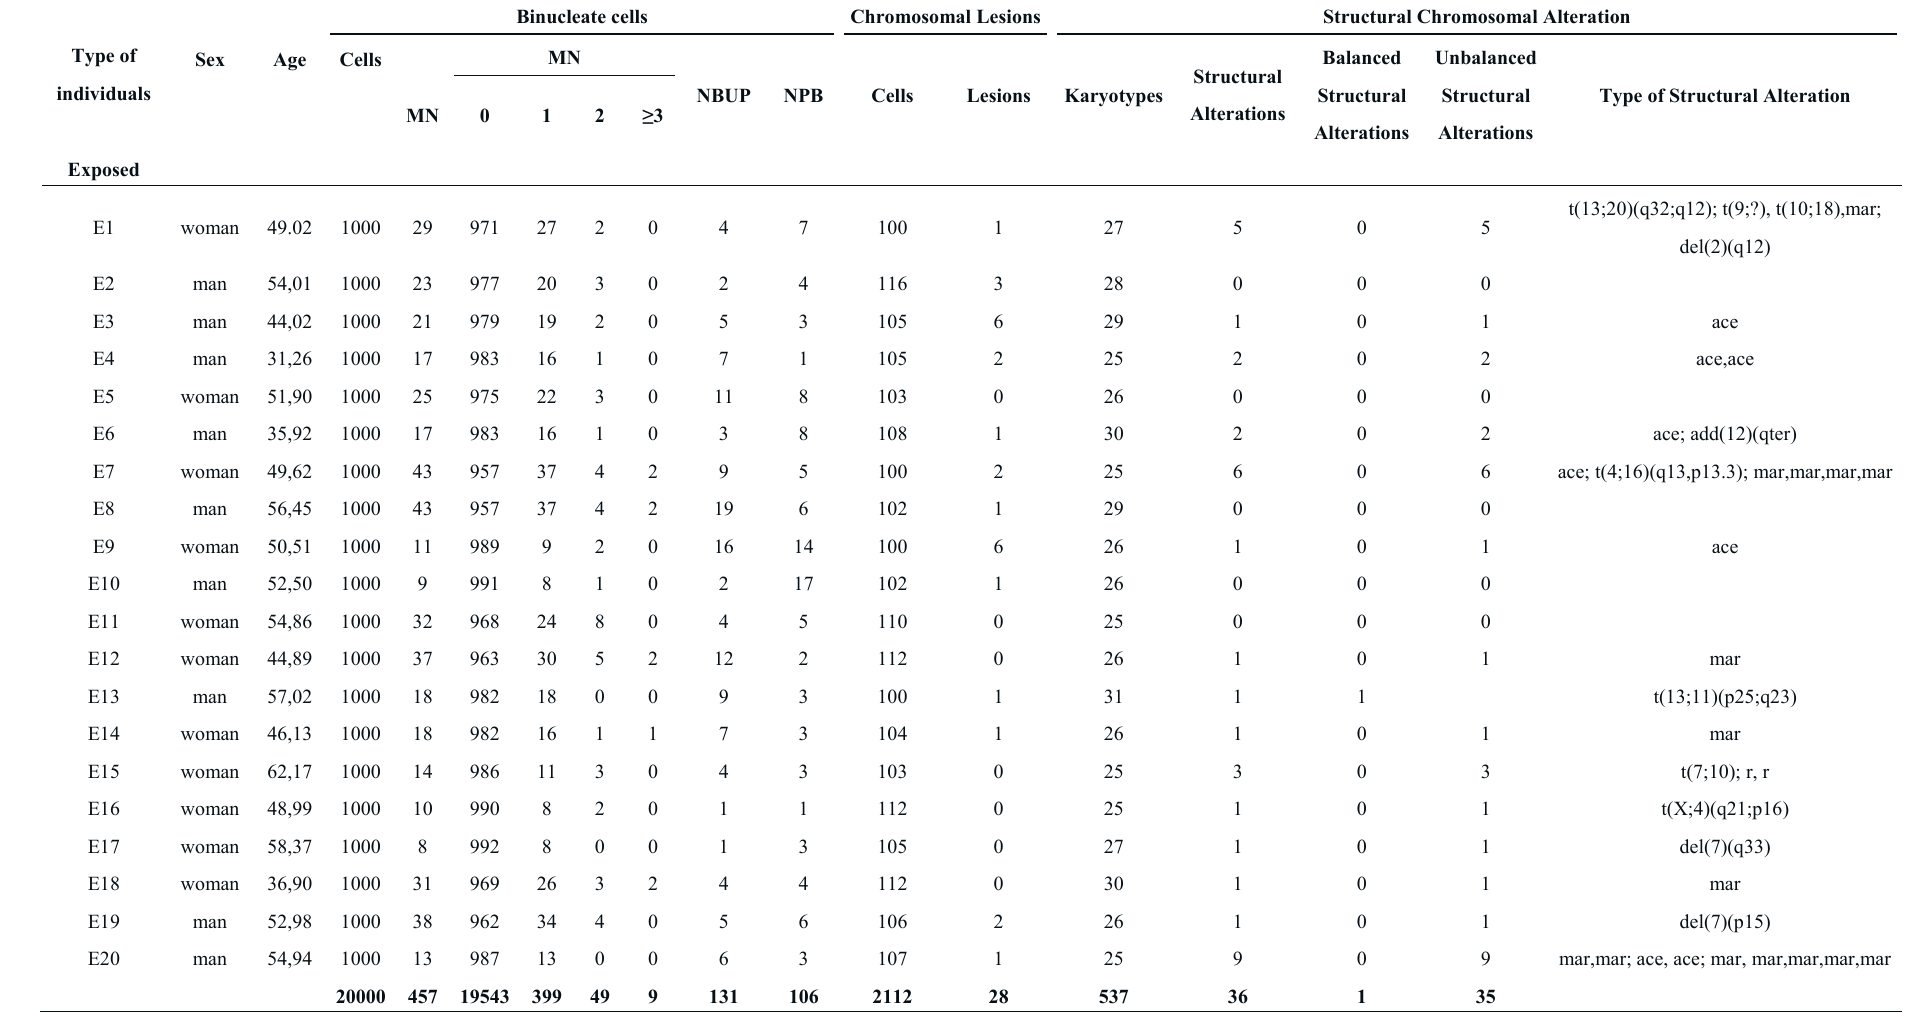
Table 2. Cytogenetic results in individuals exposed and non-exposed to